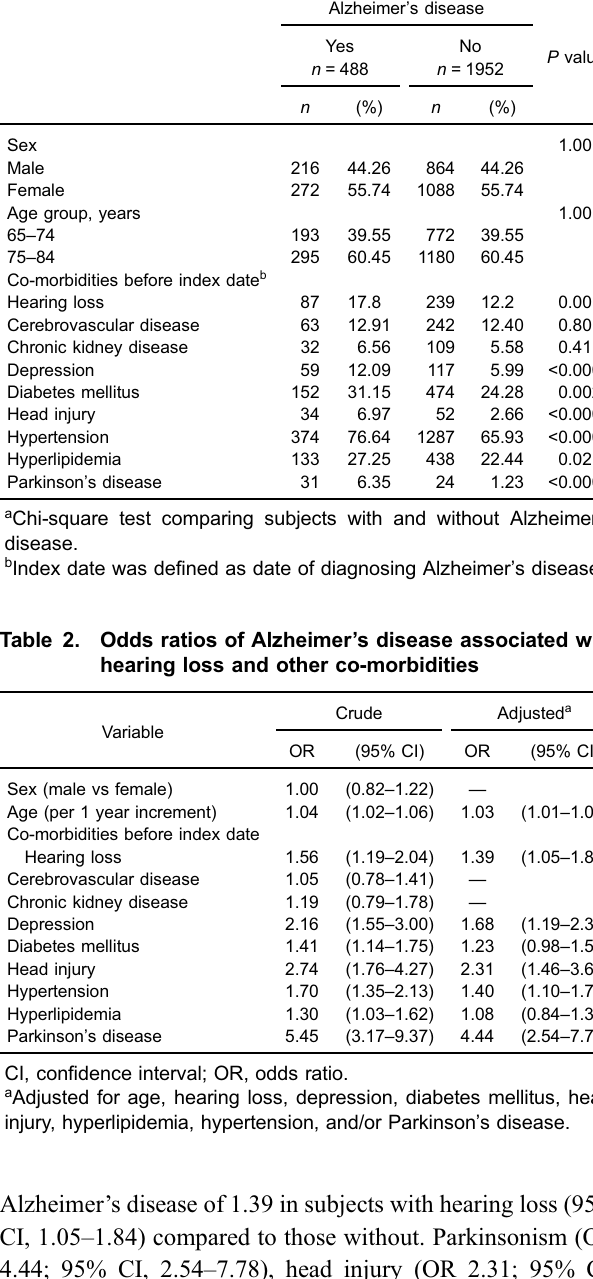
Table 1. Characteristics between Alzheimer ’ s disease cases and control subjects Alzheimer ’ s disease